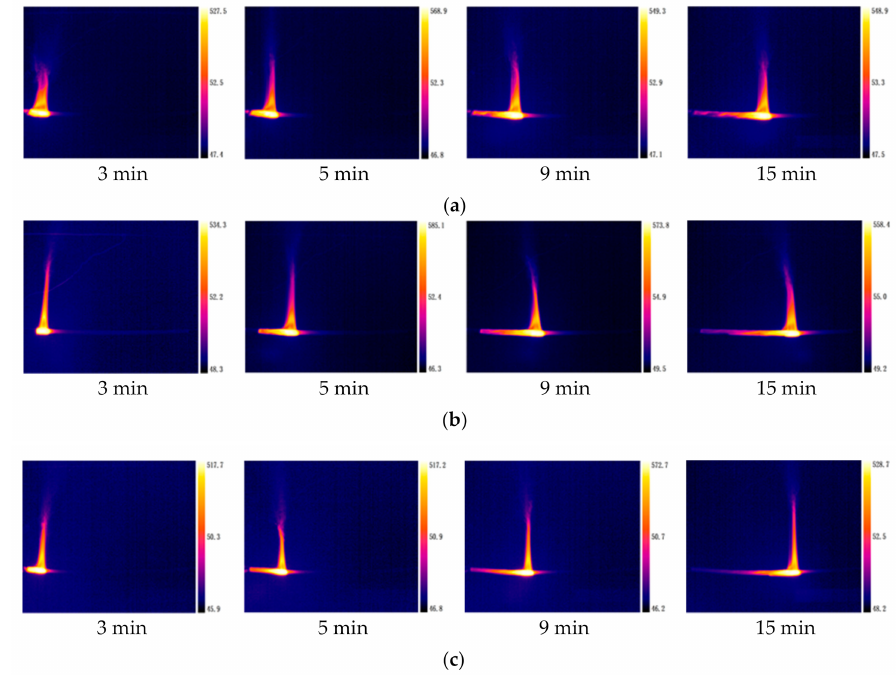
Figure 12. Temperature distribution of a single cable with di ff erent core number at di ff erent time.